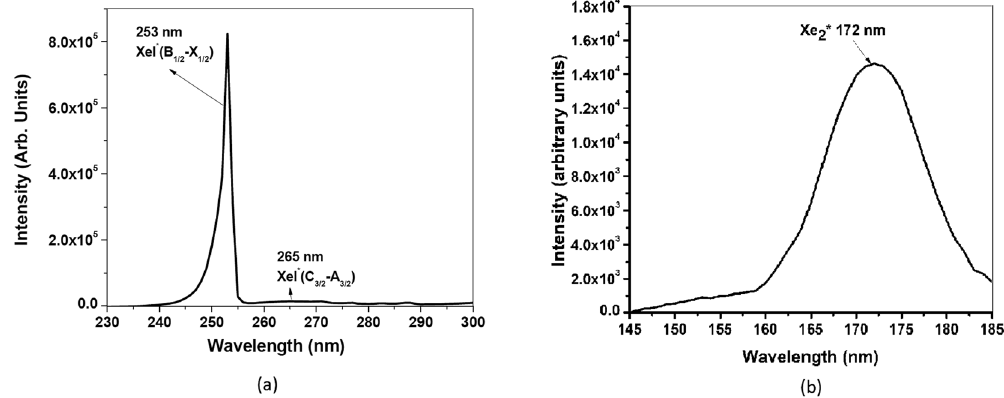
Figure 4. Simultaneously recorded spectra useful for water disinfection in ( a ) UV-C and ( b ) VUV